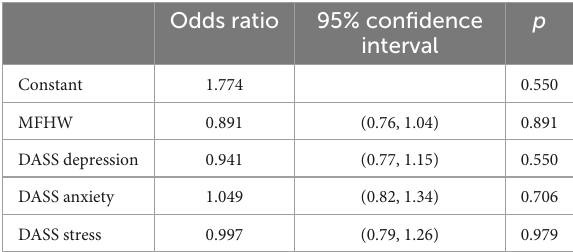
TABLE 3 Results of the binary linear regression model to assess the predictive value of the sepression anxiety stress scale (DASS) and the marburg questionnaire of habitual wellbeing (MFHW) for the dependent variable of cannabis-based treatment lasting less or more than a